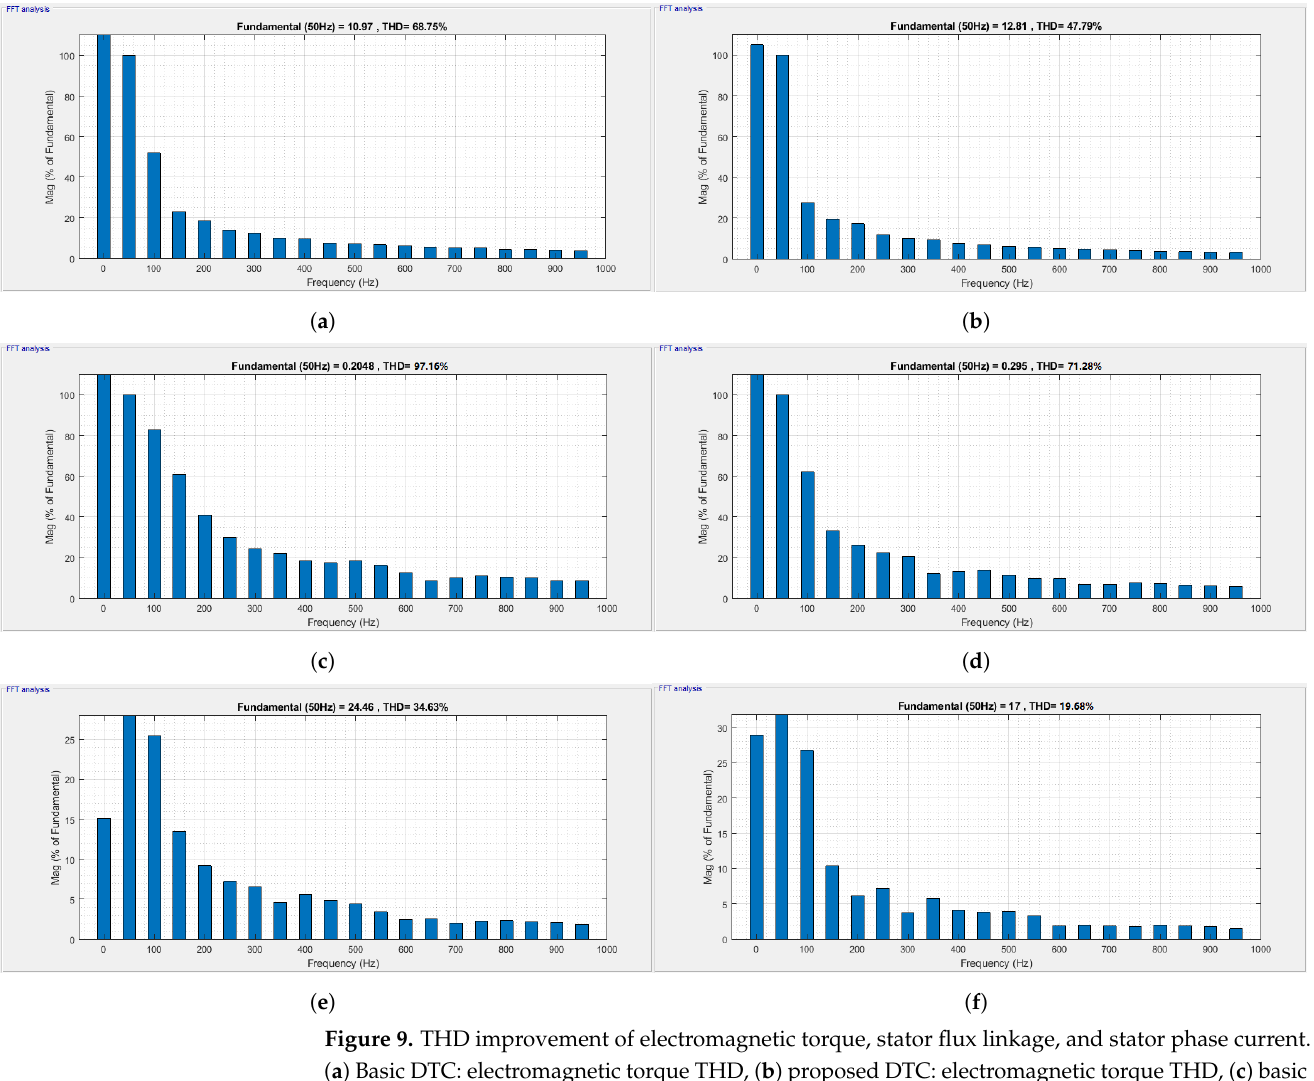
Figure 9. THD improvement of electromagnetic torque, stator flux linkage, and stator phase current. ( a ) Basic DTC: electromagnetic torque THD, ( b ) proposed DTC: electromagnetic torque THD, ( c ) basic DTC: flux of stator THD, ( d ) proposed DTC: flux of stator THD, ( e ) basic DTC: phase current THD, and ( f ) proposed DTC: phase current